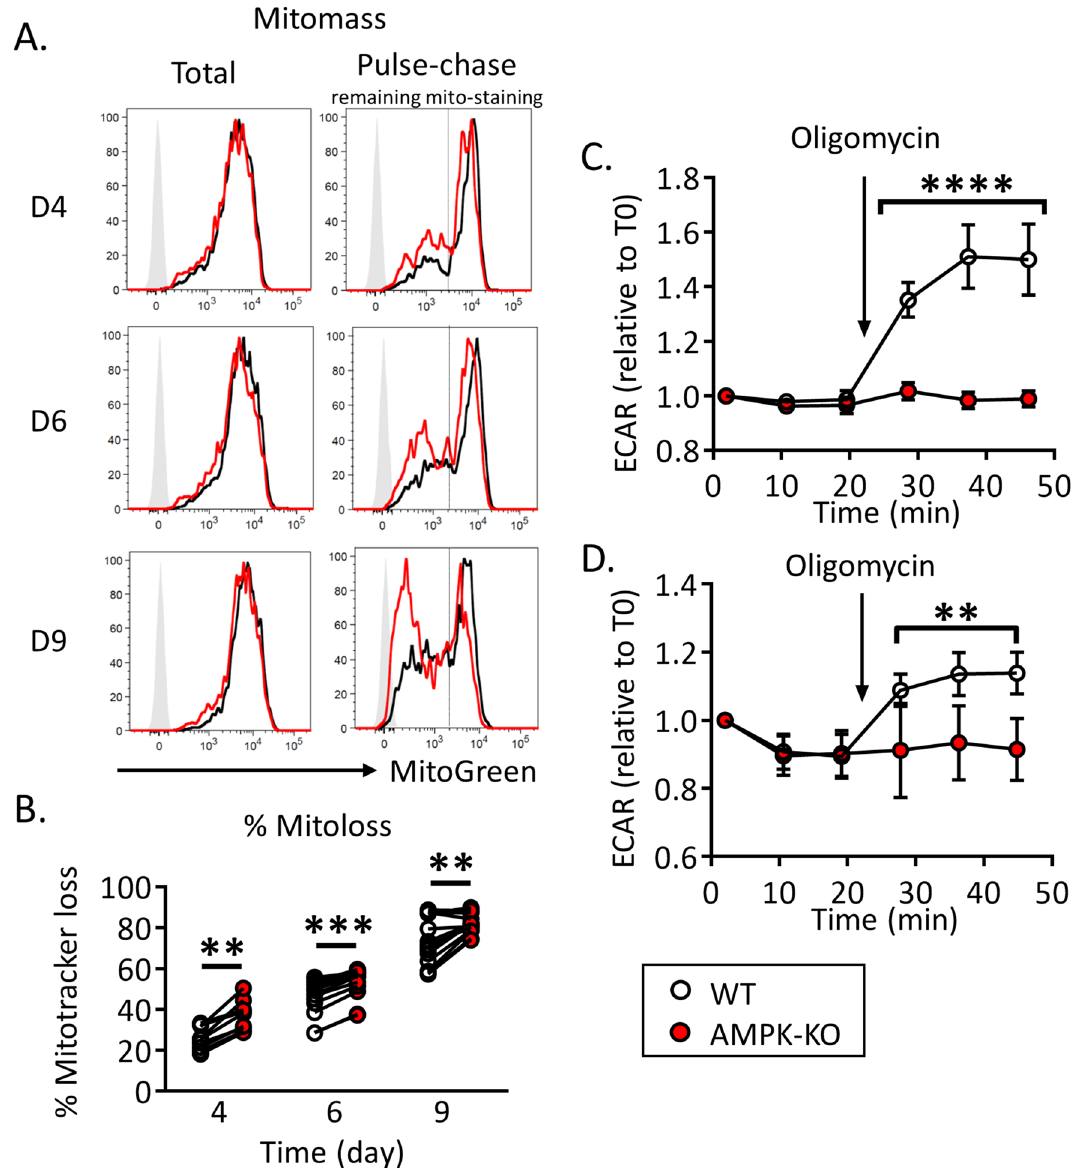
Figure 5. Accelerated mitochondrial clearance and defective mitochondrial stress-induced glycolytic switch in AMPK-KO T cells. ( A ) Representative FACS profiles of total mitochondrial mass (left panel) and pulse- chase remaining mitochondrial staining (right panels) in WT and AMPK-KO Th cells after 4, 6 and 9 day in IL-7-supplemented media. ( B ) Kinetic of mitochondrial mass loss, calculated from gate indicated in ( A , right panels). ( C , D ) Kinetic of ECAR upon oligomycin treatment of WT and AMPK-KO Th1 memory-like cells ( C ) or IL-7 + DC-expanded T cells ( D ). Data are expressed as fold increase relative to time point 0. Raw data are also provided in supplemental Figure S13. Data are pooled from 3 independent experiments (n = 9–16, B ) or 2 independent experiments (n = 6, D ), or are representative of 7 individual experiments (n = 16, C ). Statistical analysis: Wilcoxon ( B ), Mann-Withney ( C , D ). **p < 0.01; ****p <